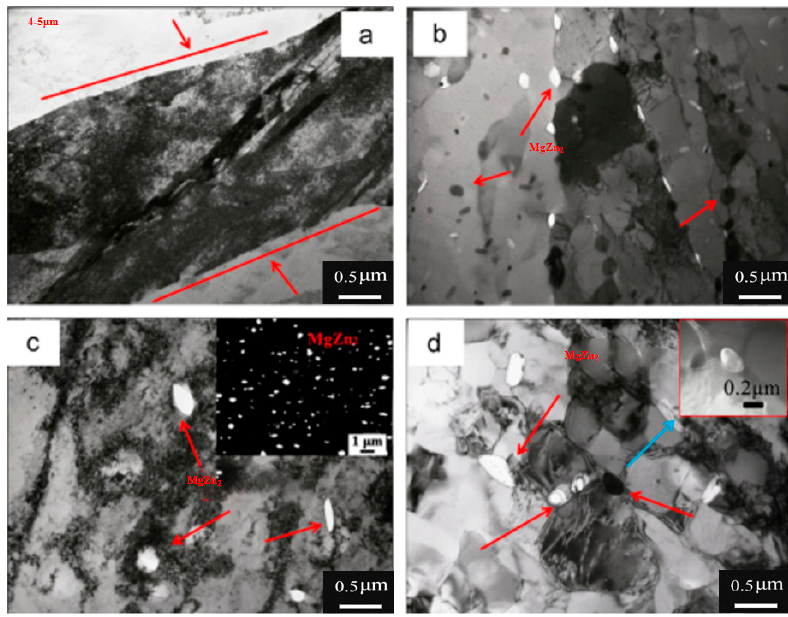
Figure 8. TEM micrographs of 7050 during N-ITMT: ( a ) W + 50% FR; ( b ) W + 50% FR + OA; ( c ) final rolled sheet (the inset in Figure 8c is the distribution of η obtained by SEM); ( d ) bright field micro- graph of partially recrystallized 7050 Al (the inset in Figure 8d is dark field micrograph of η ). The arrows in all figures correspond to η ; white spots in b, c and d are also η phases etched away during electropolishing [38].